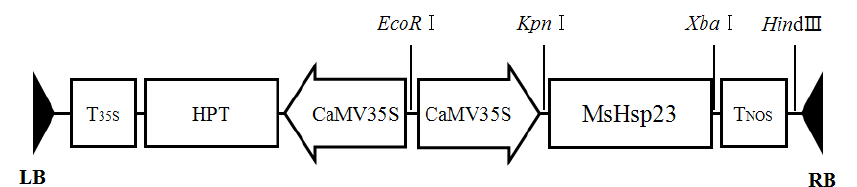
Figure 1. Schematic representation of the T-DNA region of pCAM- MsHsp23 , the expression vector used for transformation. RB, right border; LB, left border; 35S, CaMV 35S promoter; HPT, hygromycin phosphotransferase; MsHsp23, alfalfa small heat shock protein, T 35S , CaMV 35S terminator; T NOS , nopaline synthase terminator; Eco RI , Kpn I, XbaI and Hin dIII restriction